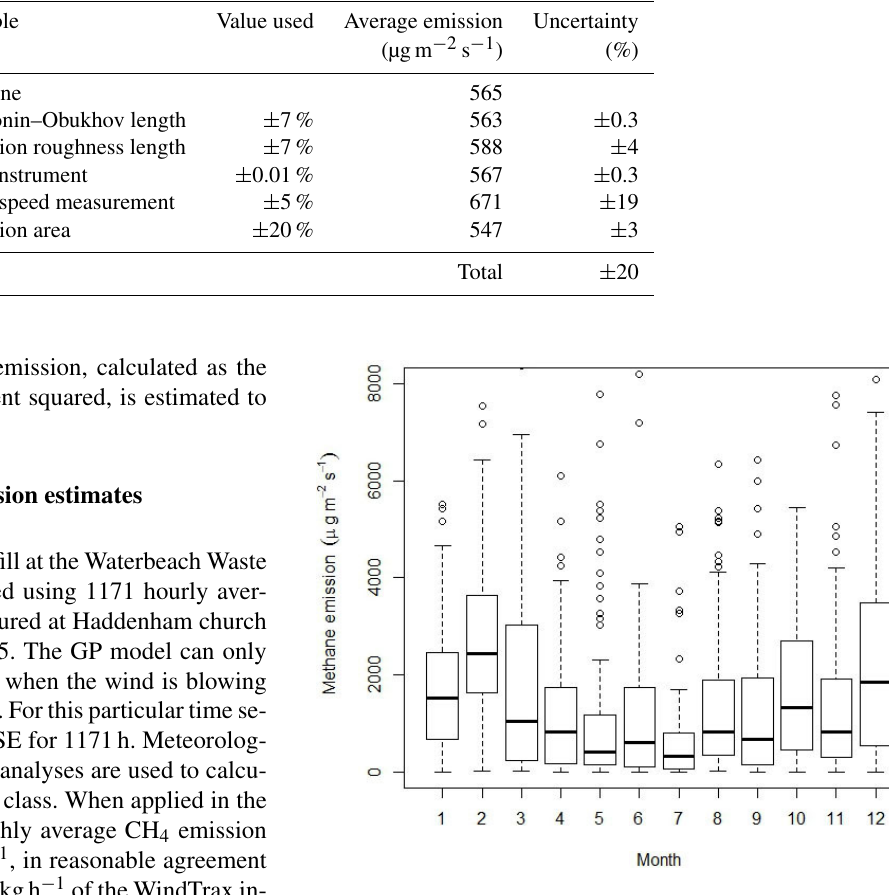
Figure 6. Box plot of hourly emissions calculated using the Gaus- sian plume modelling approach showing the monthly variability in methane emissions using data from 2012 to